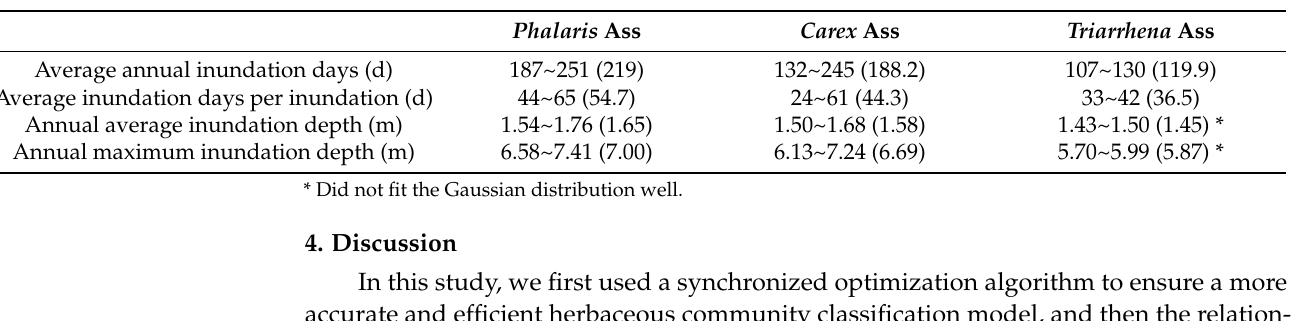
Table 2. The optimal hydrological niche (optimum) of each wetland herbaceous community in the study